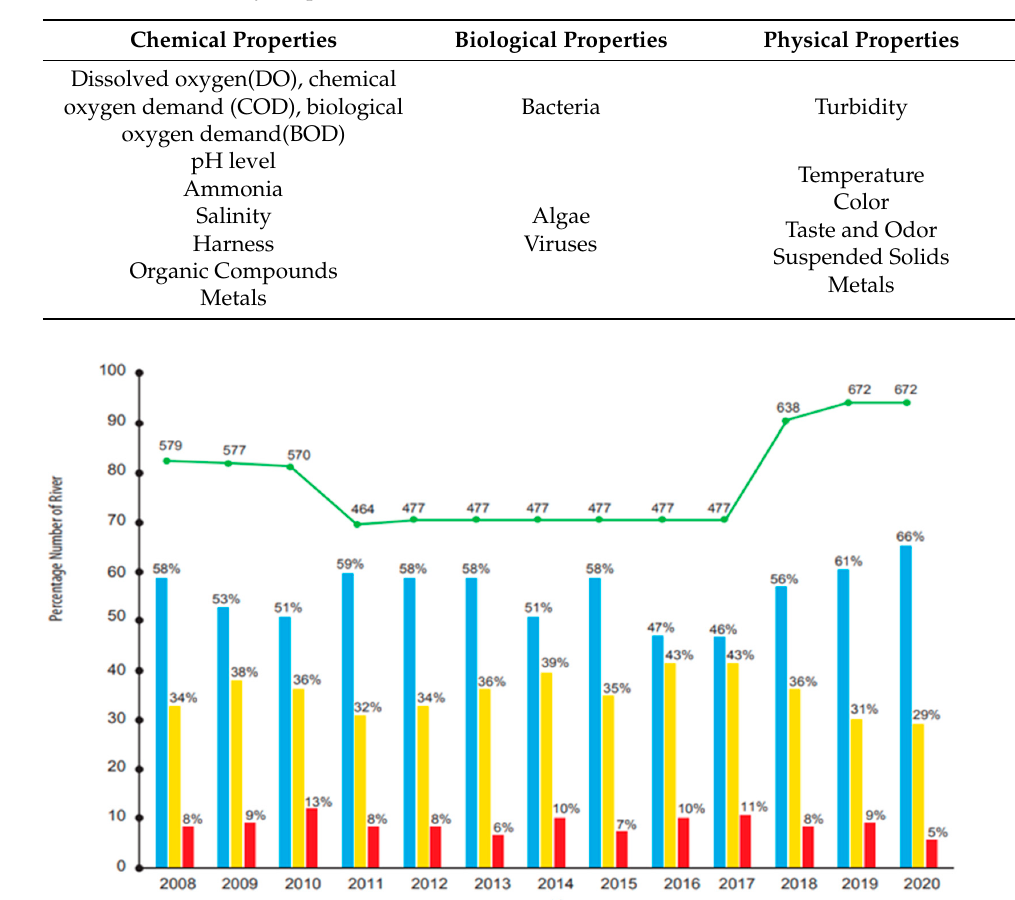
Figure 1. River Water Quality Trends from 2008 until 2020 year versus percentage number of rivers (%) in Malaysia [13]. Blue bar chart refers to unpolluted rivers; yellow bar chart refers to slightly polluted rivers; red bar chart refers to polluted rivers; green line shows total number of rivers.